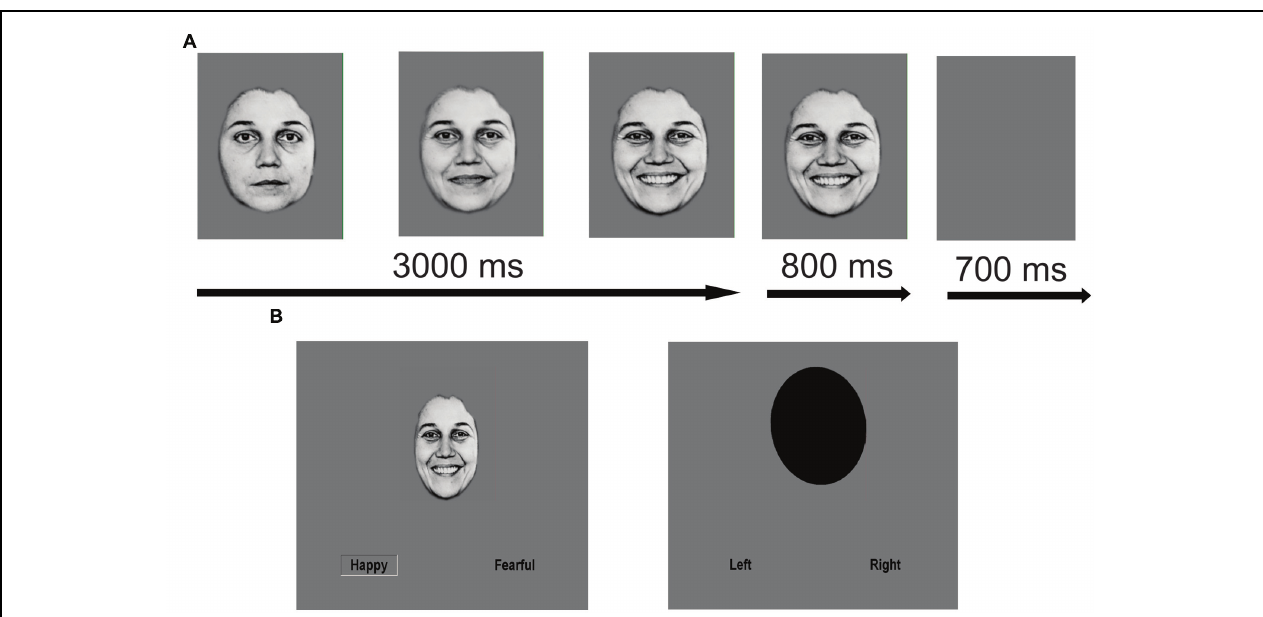
FIGURE 1 | Schematic of facial emotion identification task. Facial emotion identification task with dynamically morphing face stimuli. On FACE trials, a screen displaying text of the three possible emotions to discern (FEAR, HAPPY, SAD) was presented for 1500 ms. Next, a neutral face morphed smoothly and dynamically to an emotion of prototypical intensity over the span of 3000 ms. At maximal emotion intensity, the face remained on the screen for an additional 800 ms of the trial before the screen turned blank for 700 ms. At stimulus onset, two possible emotion choices were displayed in text on the bottom left and right corners. Subjects were instructed to press one of two buttons corresponding to the displayed emotion as soon as they recognized the emotion of the face. OVAL trials were used as a sensorimotor control (6 s per trial), where subjects had to determine if the top of an oval was tilting to the left or right and make a button response accordingly as soon as they recognized the tilt direction. (A) Example FACE stimulus (enlarged for purposes of clarity). (B) Sample FACE and OVAL trial. Reproduced with permission.